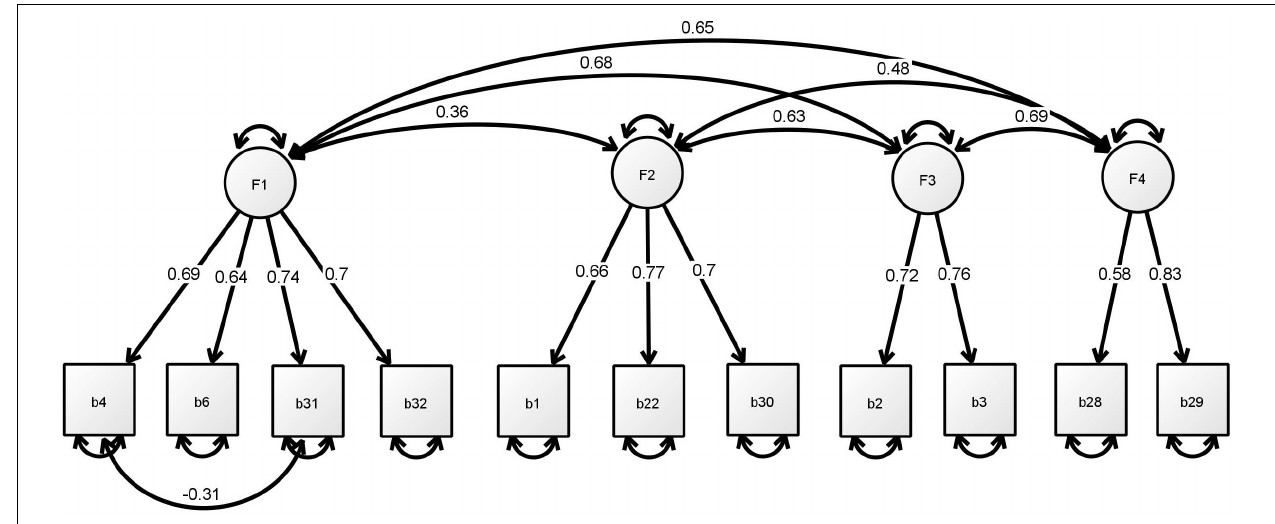
FIGURE 1 | Final standardized model of the 11-item BSCS. F1, self-discipline; F2, impulsivity; F3, healthy habits; F4,